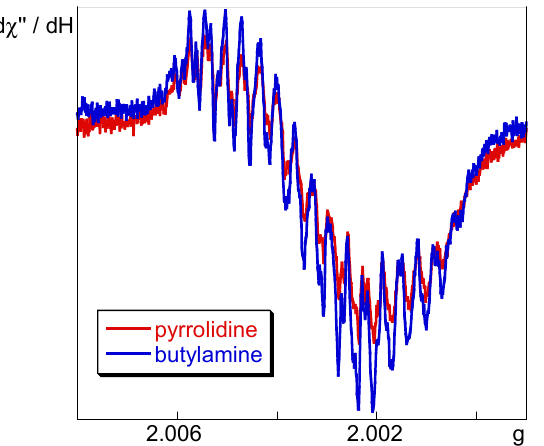
Figure 4. EPR spectra for the interaction of an equimolecular solution (2 × 10 − 3 M in DMSO/water 4:1 v / v ) of 1 and pyrrolidine or n -butylamine. The measurements started at 20 min (pyrrolidine) and 6 min ( n -butylamine) after the addition of the amine. Experimental details of the data collection: modulation amplitude 0.01 mT, time constant 40.96 ms, conversion time 327.68 ms, gain 6.32 × 10 4 , and power 20 mW in all cases. Microwave frequencies were 9.7718 (pyrrolidine, three scans) and 9.7713 GHz ( n -butylamine, four scans).